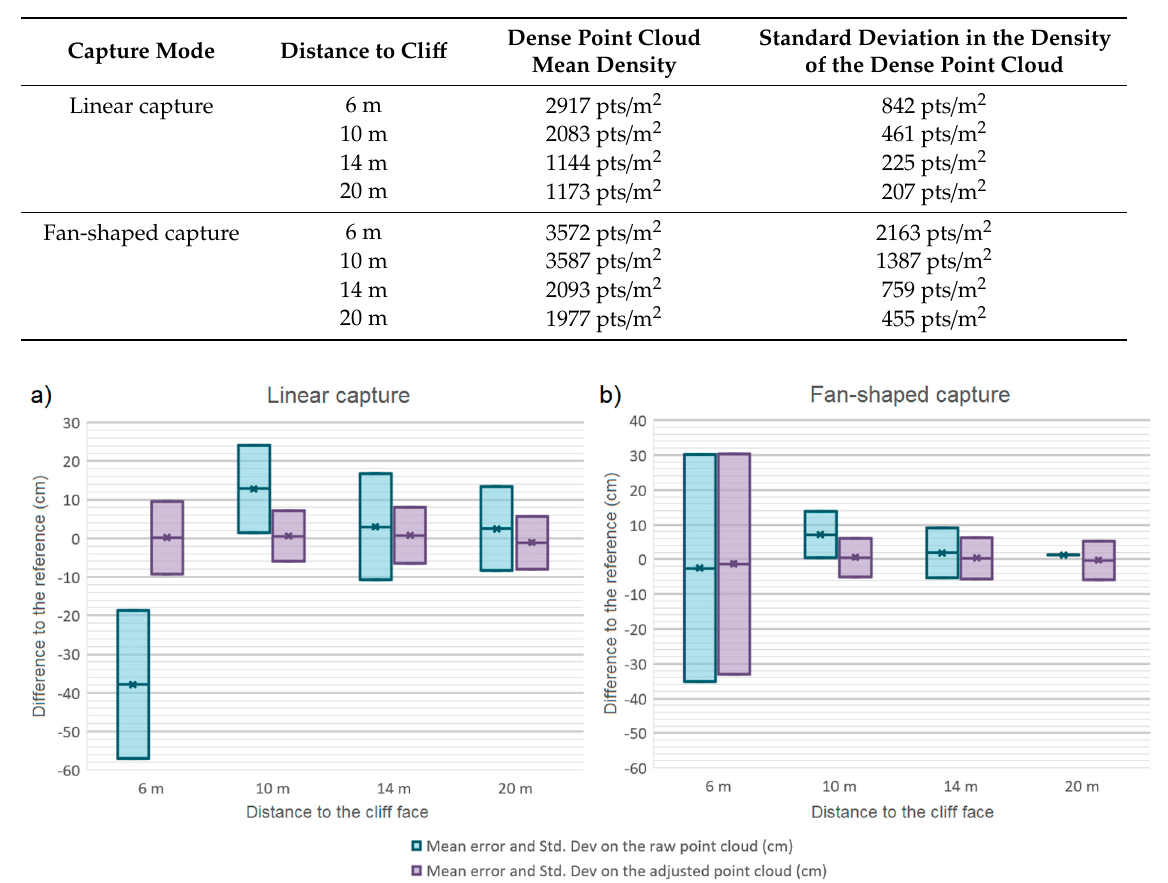
Figure 7. Mean error and standard deviation for the SfM point clouds resulting from the different survey protocols compared to the TLS mesh. ( a ) Linear capture, ( b ) Fan-shaped